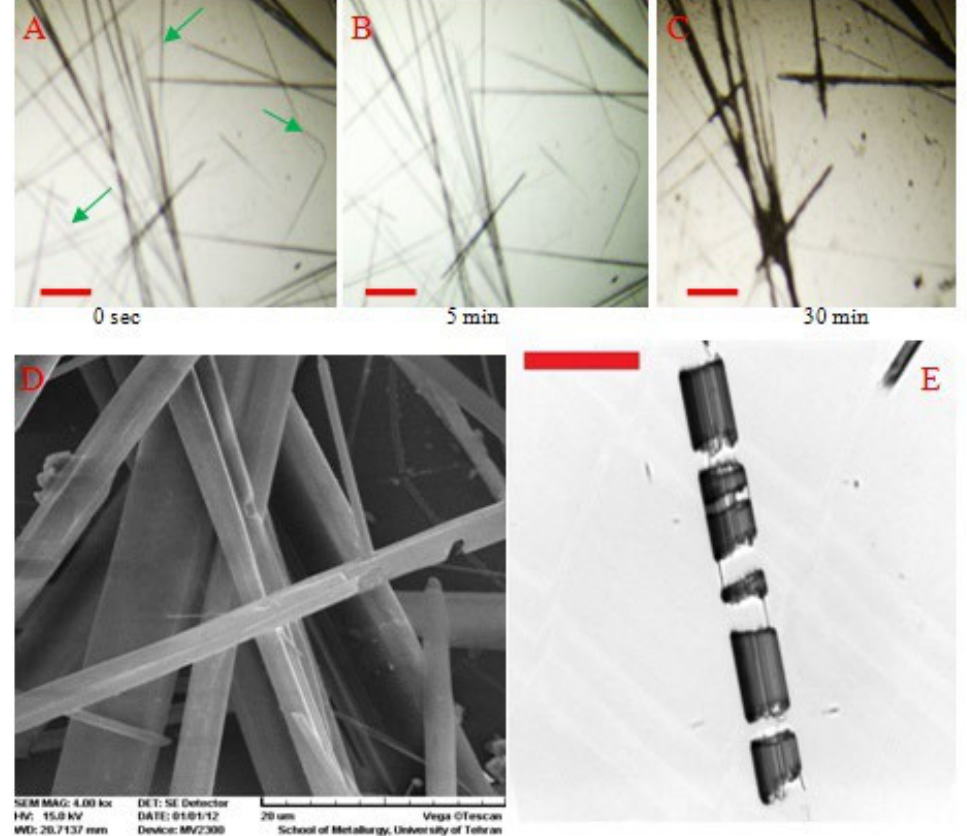
Figure 2. ( A – C ) Optical microscopy images of diphenylalanine (FF) micromaterials in the phosphate buffer solution at regular time intervals. Reprinted with permission from [56]. SEM images of the micromaterials after incubation in the buffer solution ( D ) and in methanol ( E ) for a few minutes (reprinted with permission from [58]). Copyright (2015) American Chemical Society. Green arrows indicate completely dissolved nanostructures. Scale bar corresponds to 200 µm.